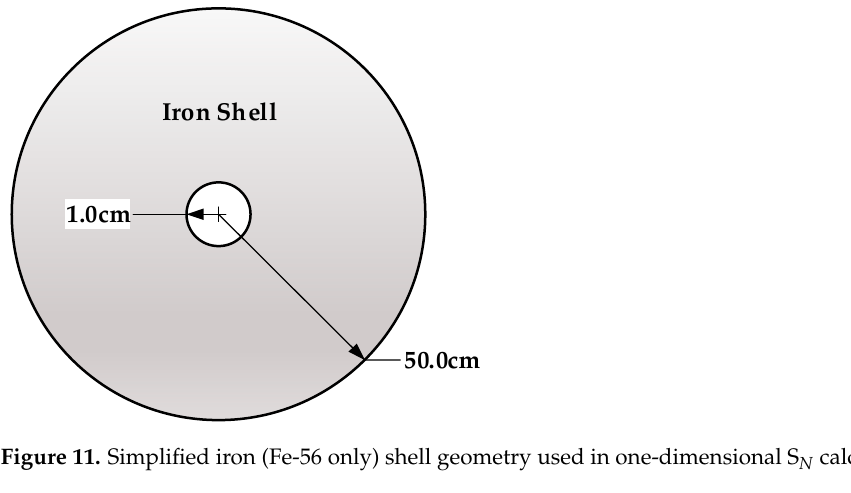
Figure 10. Cf-252 source neutron leakage spectra of iron spheres with six di ff erent thicknesses. ( a ) Shell 1: thickness 6.476 cm. ( b ) Shell 2: thickness 8.976 cm. ( c ) Shell 3: thickness 11.476 cm. ( d ) Shell 4: thickness 13.976 cm. ( e ) Shell 5: thickness 16.476 cm. ( f ) Shell 6: thickness 18.976 cm.